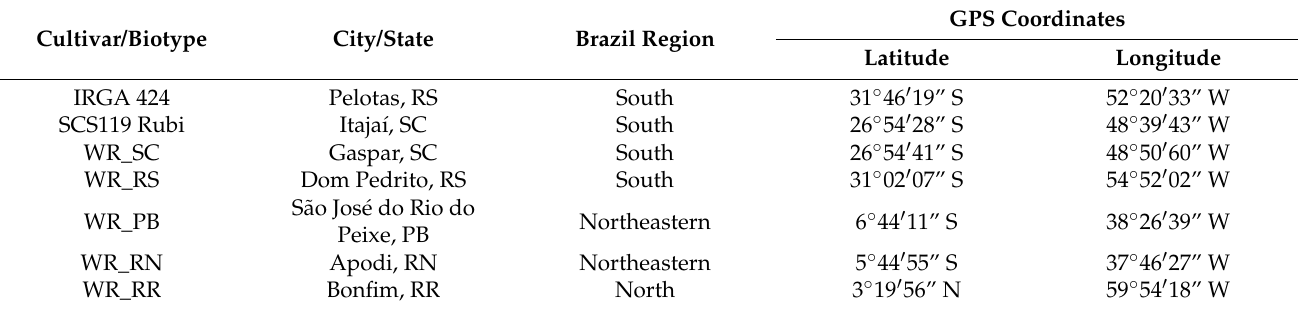
Table 1. Geographic origin of rice cultivars and weedy rice accessions used in the study.